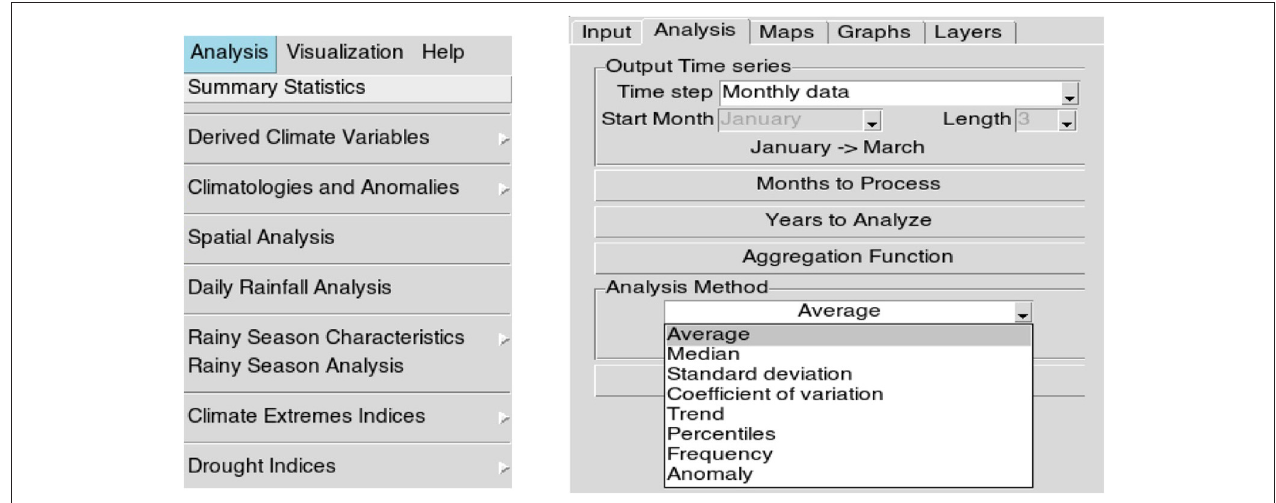
FIGURE 4 | CDT analysis menu.